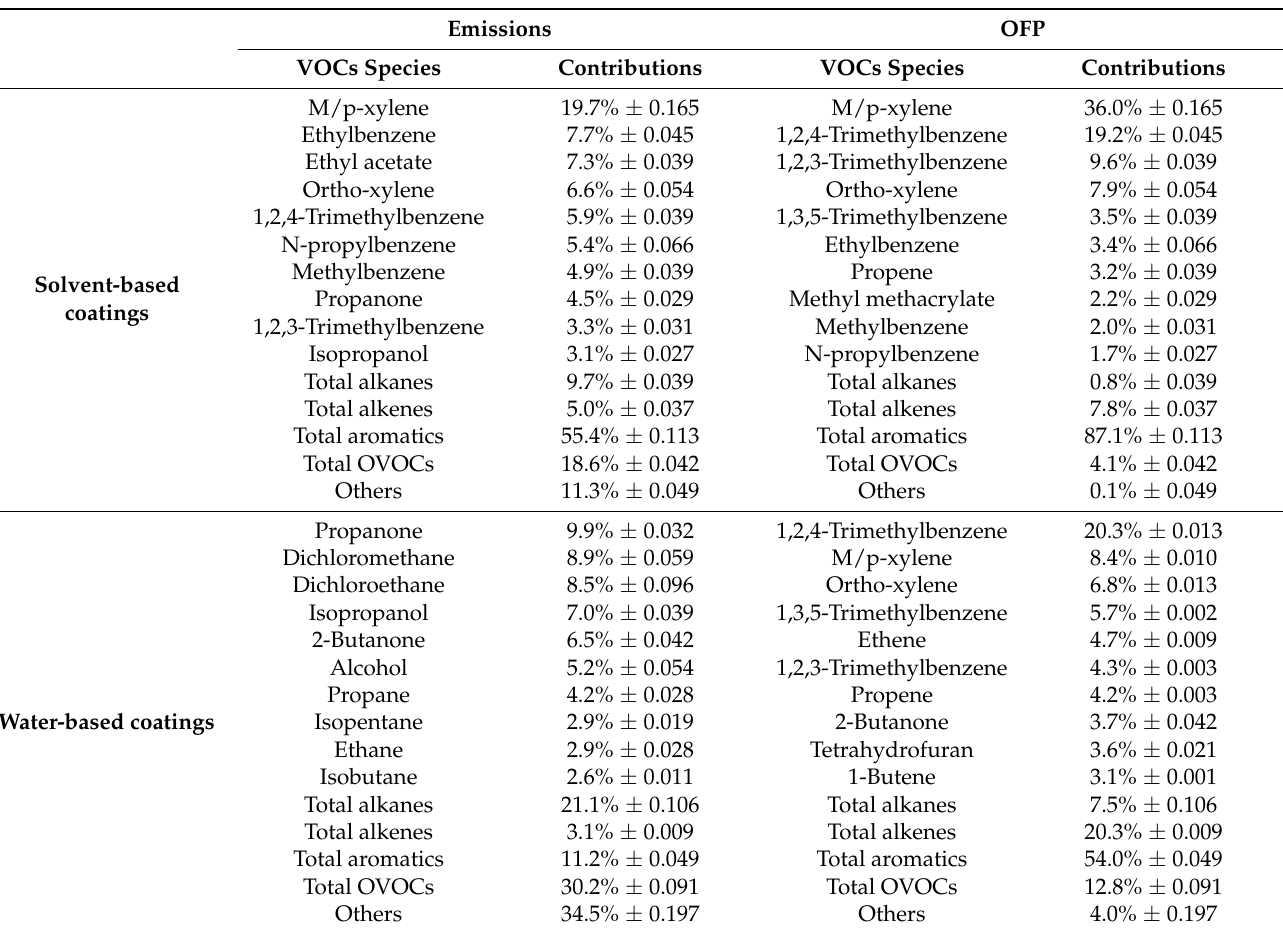
Table 4. The proportions of main VOCs species and chemical groups contributing to VOCs emissions and OFP for solvent-based coatings and water-based